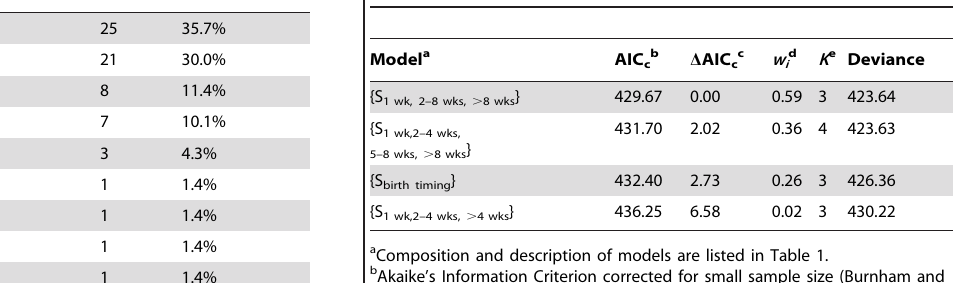
Table 3. Top-ranked survival models of neonate bighorn sheep from birth to 52 weeks post capture in the Black Hills, South Dakota, USA, 2010–2012 when cˆ (a model term representing overdispersion) was 1.0 (i.e., assumed no